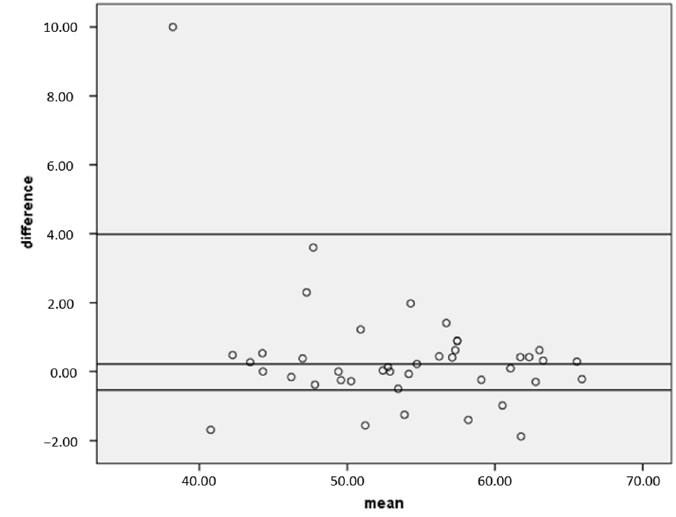
Figure 2. Bland–Altman